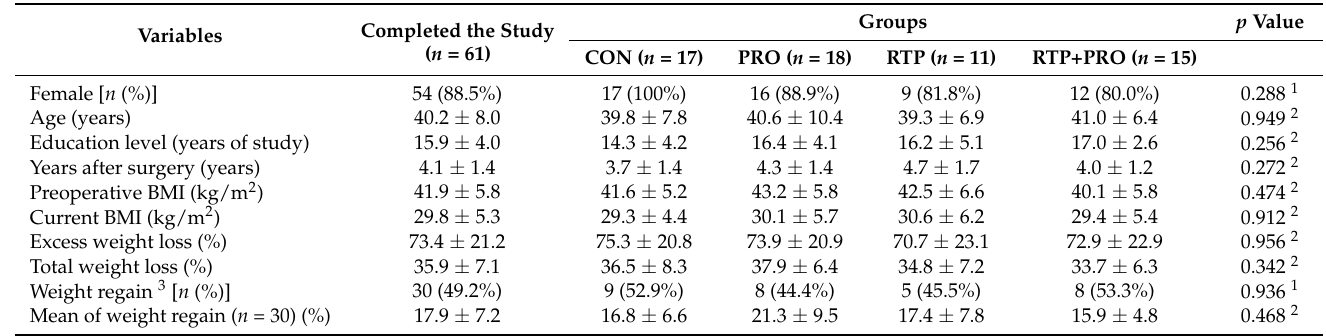
Table 1. Baseline sociodemographic, clinical, and anthropometric characteristics of participants in the mid-to-late postoperative period after Roux-en-Y gastric bypass, according to the intervention groups.